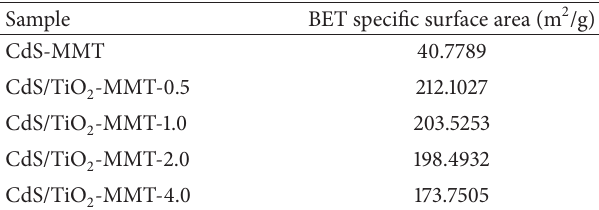
Table 1: Specific surface area of CdS/TiO